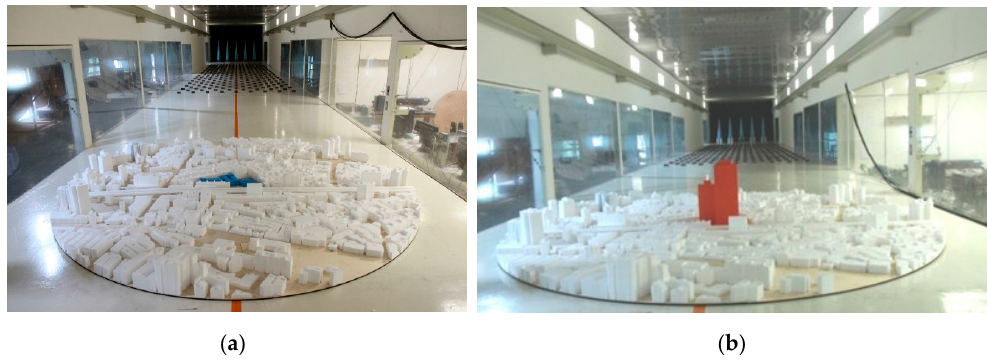
Figure 1. Wind-tunnel test model. ( a ) Before urban renewal; ( b ) after urban renewal.